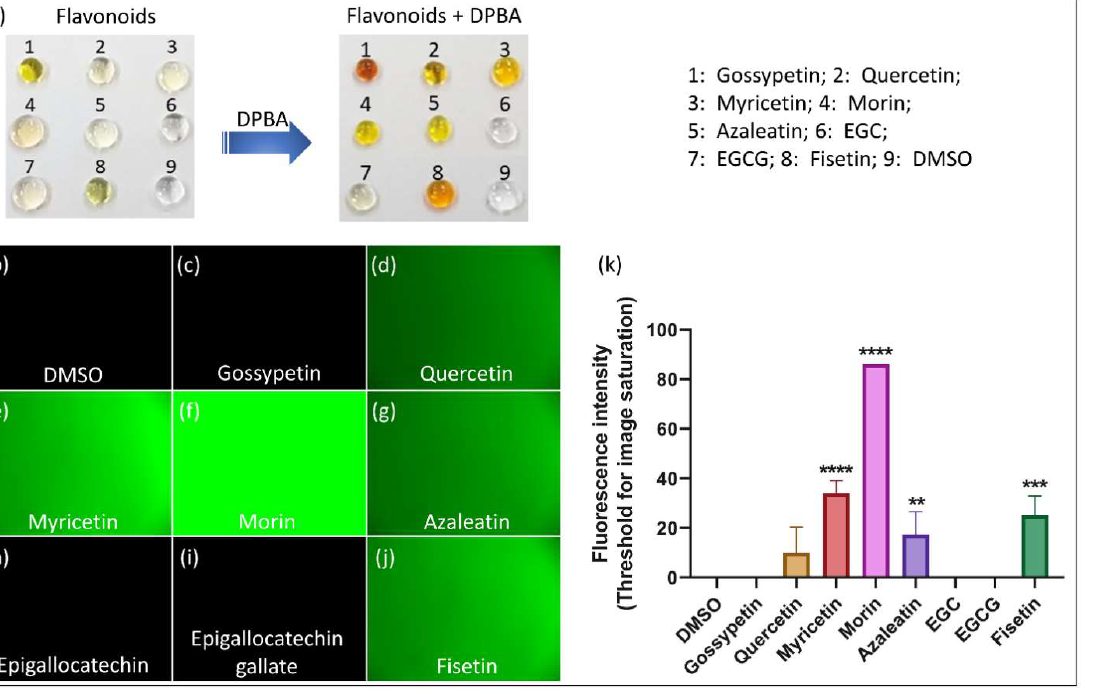
Figure 5. In vitro investigation of fluorescence response of flavonoids after interaction with DPBA. ( a ) Images of the flavonoid droplets on silanized glass slide before and after their treatment with DPBA. The concentration of flavonoids prepared in DMSO is 100 mM while the concentration of DPBA solution used for the treatment is 0.5% in EtOH. The 1:1 ( v / v ) mixture was dropped (~1 μL) on the silanized glass slide. ( b – j ) Optical microscopic images (Ex. 470 nm) of the flavonoids treated with DPBA where morin, myricetin, fisetin, azaleatin and quercetin exhibited fluorescence and ( k ) a comparison of their relative intensity. The error bars represent the mean ± SEM. **** p < 0.0001, *** p < 0.001, ** p < 0.01, one-way ANOVA followed by Tukey’s multiple comparisons test ( k ).